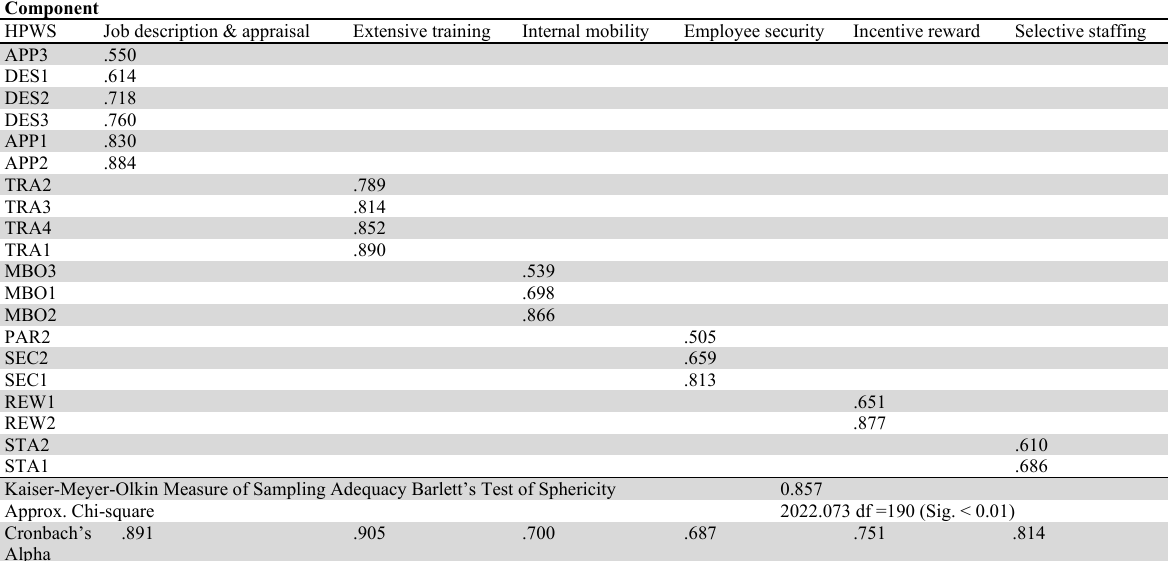
Exploratory factor analysis results of HPHR